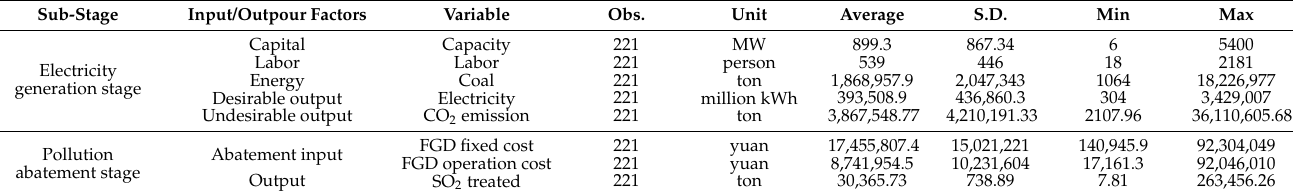
Table 1. Input and output factors.